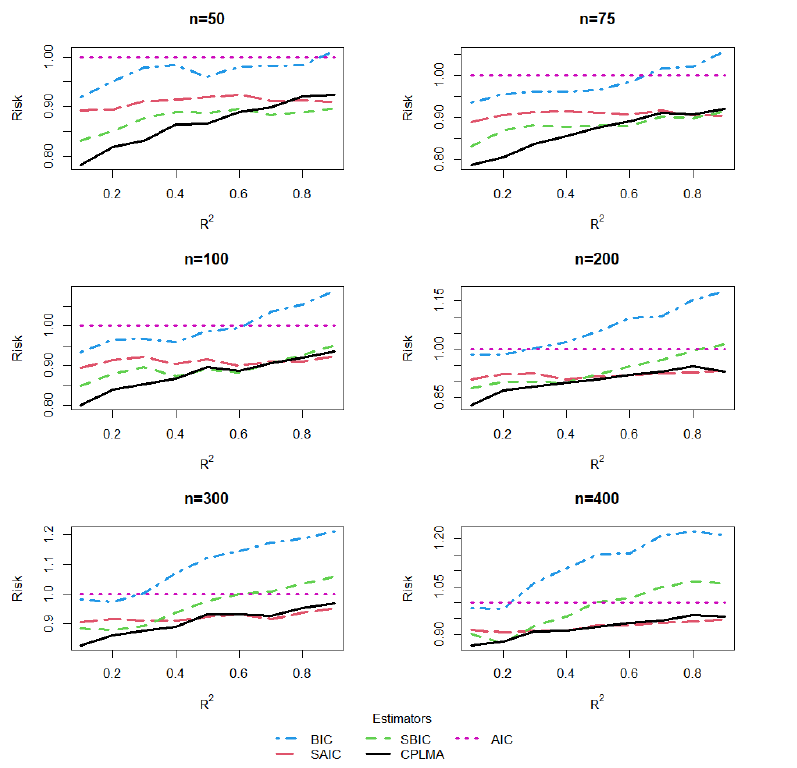
Figure 2. Risk comparisons for Design 1 when α = 2 and the censoring rate is about